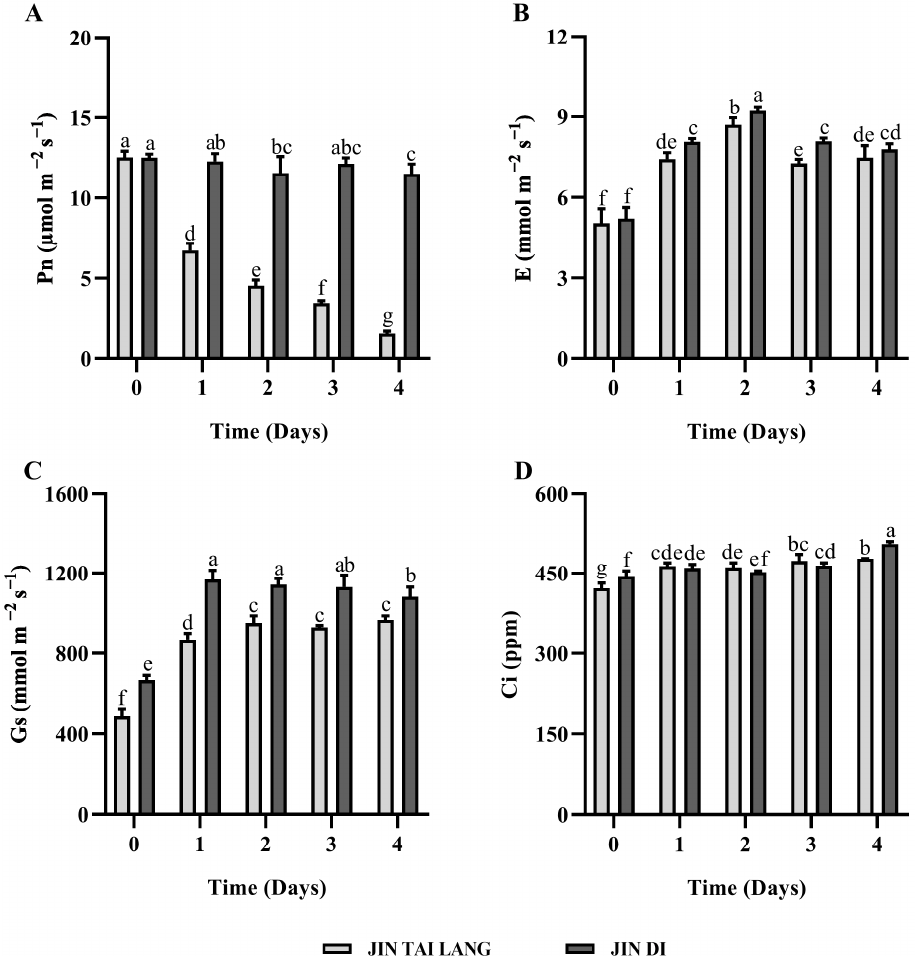
Figure 4. Changes of gas exchange parameters in leaves of two melon seedlings under HTH stress. ( A ), net photosynthetic rate(Pn); ( B ), transpiration rate (E); ( C ), stomatal conductance (Gs); ( D ), intracellular CO2 concentration (Ci). Different letter indicates significant differences according to Duncan’s multiple range test at p < 0.05 using a one-way ANOVA. Values are represented as the means ± SD ( n = 6).